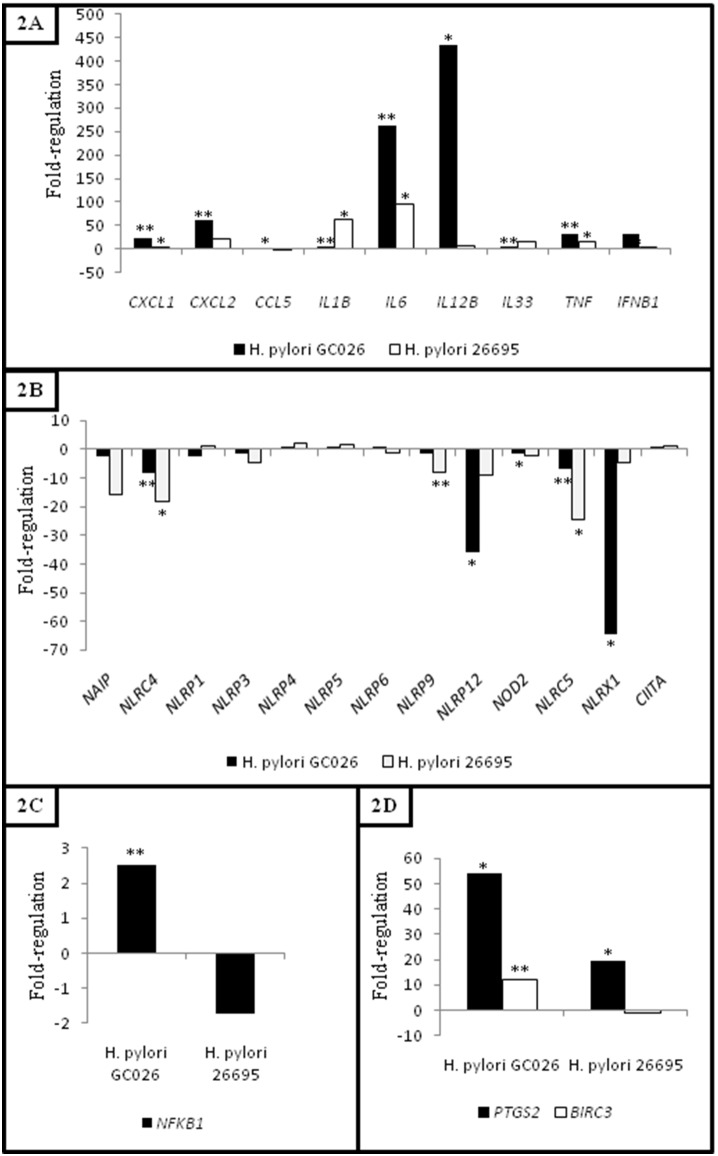

Helicobacter pylori up-regulates NFKB1 and NF-κB target genes, and down-regulates NF-κB-negative regulators.A) Gene expression of cytokines and chemokines in H. pylori-challenged THP-1 cells, B) Gene expression of NOD-like receptors in H. pylori-challenged THP-1 cells, C)
NFKB1 expression in H. pylori-challenged THP-1 cells and D)
PTGS2 and BIRC3 expression in H. pylori-challenged THP-1 cells. Fold-change (2∧(−Delta Delta Ct)) is the normalized gene expression (2∧(−Delta Ct)) in THP-1 cells challenged with H. pylori (GC026 and 26695) divided the normalized gene expression (2∧(−Delta Ct)) in their respective control group. Fold-regulation represents fold-change results in a biologically meaningful way. Fold-change values greater than one indicate up-regulation, and the fold-regulation is equal to the fold-change. Fold-change values less than one indicate down-regulation, and the fold-regulation is the negative inverse of the fold-change. Fold-difference compared to the control group showing a *P-value<0.05 and a **P-value<0.01. P-values were obtained with a Student’s t-test.